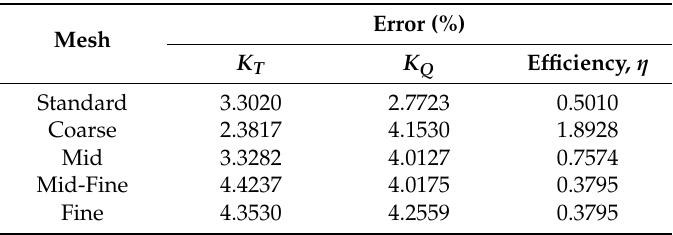
Table 4. Computational results at different mesh resolutions with a standard k- ω turbulence model for J =